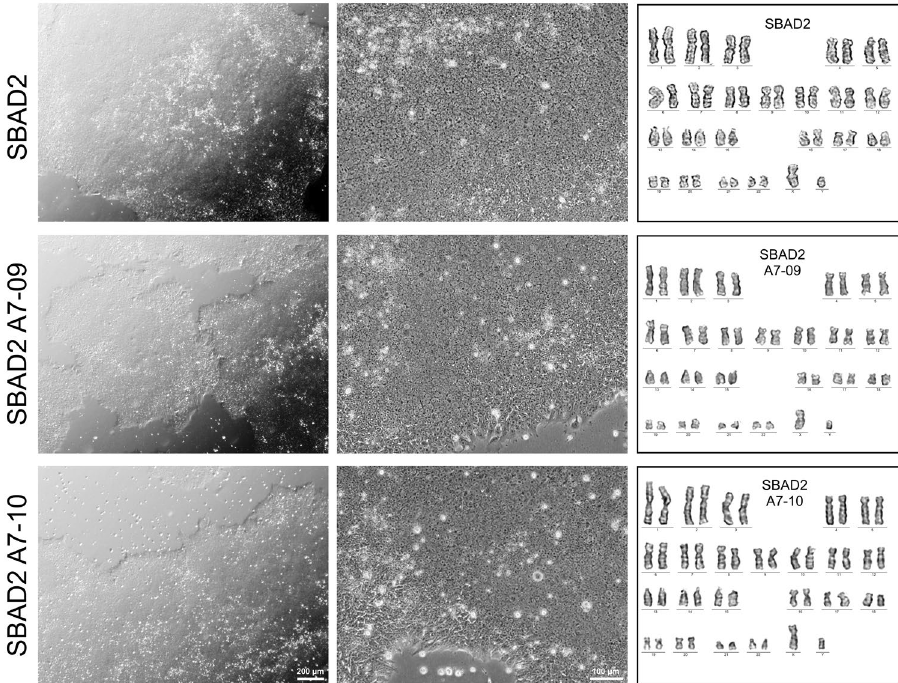
Figure 4. iRFP720 expressing hiPSCs show normal stem cell characteristics and karyotype. Brightfield images depicting the proper iPSC-morphology of the SBAD2 and SBAD2-iRFP720 reporter hiPSCs. Scale bars: 200 μm (left panels) and 100 μm (middle panels). Karyogram of the cell lines showed normal 46 chromosomes